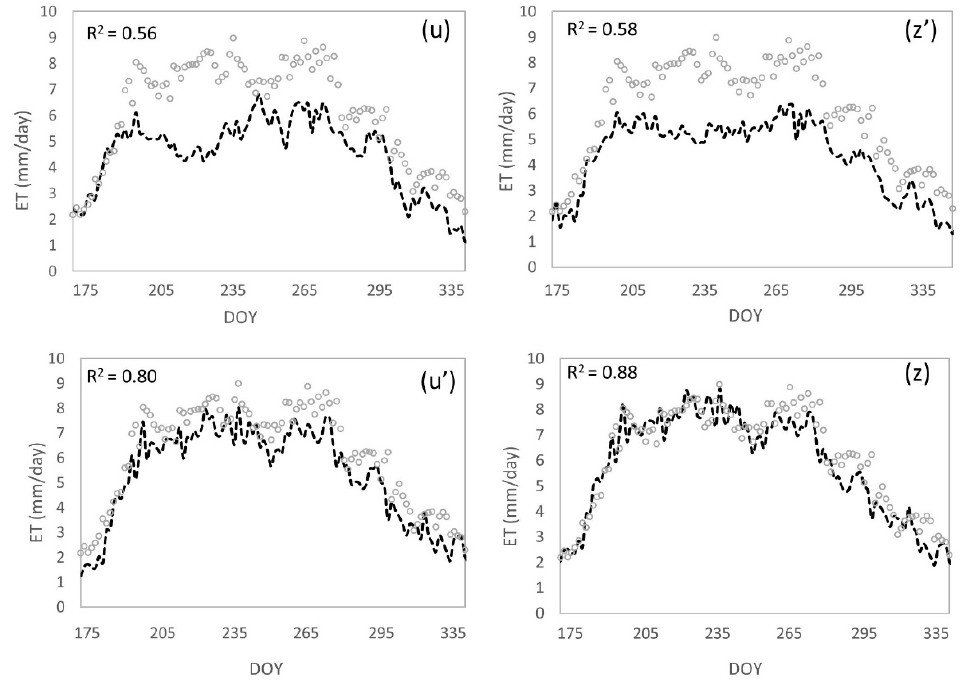
Figure 9. Time series of ET estimates using ( u ) the METRIC model only (non-fusion approach, with four Landsat imagery), ( z’ ) the original fusion model before any modifications ( u’ ) the modified fusion model with selective filter ( z ) the modified fusion model with selective filter and weighting coefficient (the default approach). Note that: the circles in the figures show the daily actual ET values generated based on the multiplying the reference ET by crop coefficient in each growth stage, and the dashed line show average of daily ET values extracted from pixels correspond to agricultural farmlands